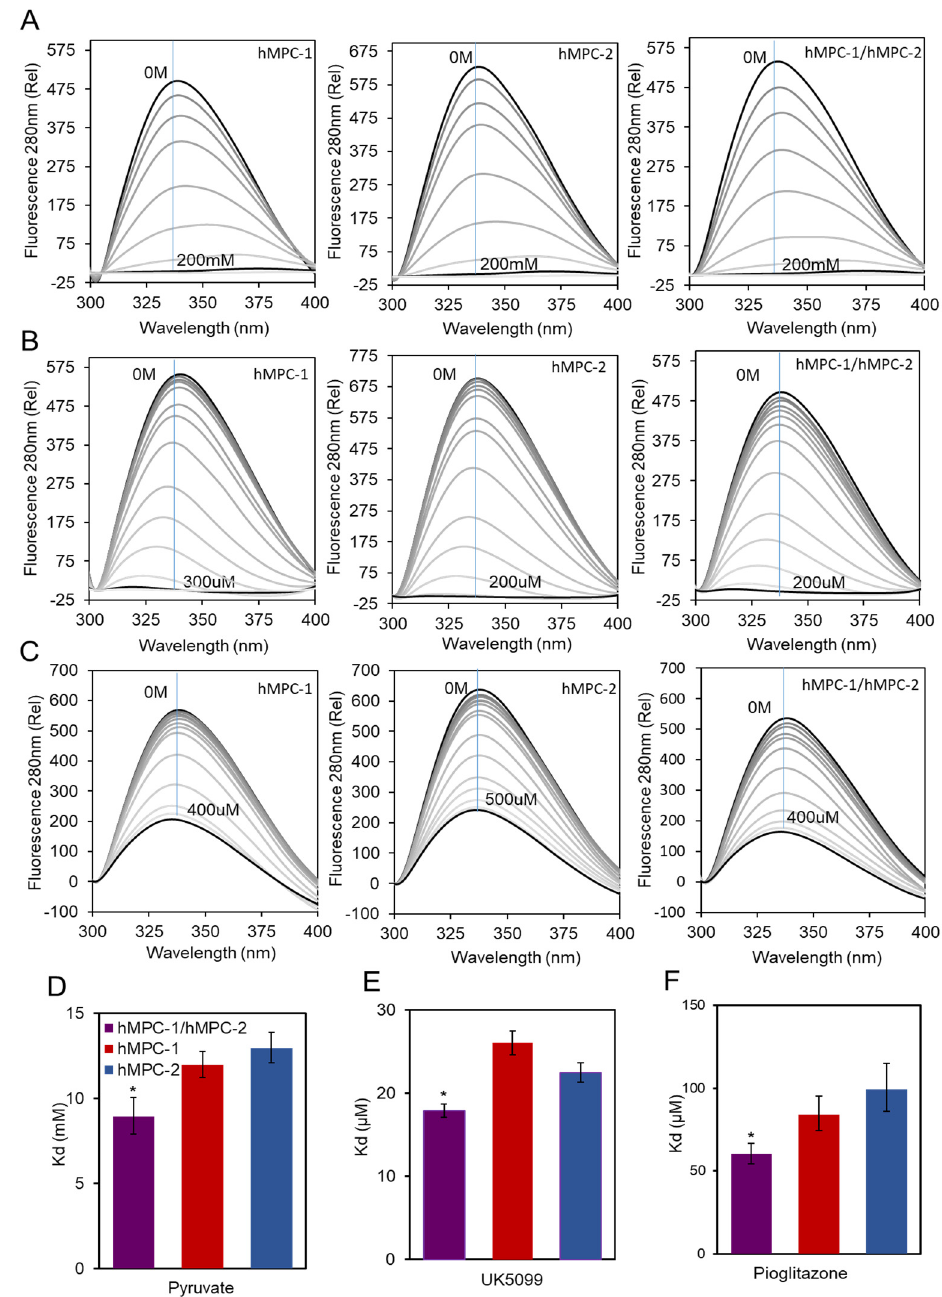
Figure 4. Molecular interaction of hMPCs with substrates and inhibitors. Fluorescence spectrum of hMPC-1, hMPC-2, and hMPC-1 / hMPC-2 on the titrating of ( A ) pyruvate up to 200 mM, ( B ) UK6099 up to 200 or 300 µ M, and ( C ) pioglitazone up to 400 or 500 µ M. The blue line indicates the intensity values in the 338nm wavelength of each spectrum used for calculating the dissociation constants. The equilibrium dissociation constants (K d ) of hMPCs were calculated using a fluorescence quenching assay with ( D ) pyruvate, ( E ) UK6099, and ( F ) pioglitazone. The K d values for hMPC-1 (red), hMPC-2 (blue), and hMPC-1 / hMPC-2 (purple) for each ligand are summarized in Table S1. Errors were determined based on three replicated experiments. The error bars represent the standard deviation (SD), n = 3. * p = 0.05. 2.4. The hMPC-1/hMPC-2 Heterodimer Has a Greater Stability Than Homodimers